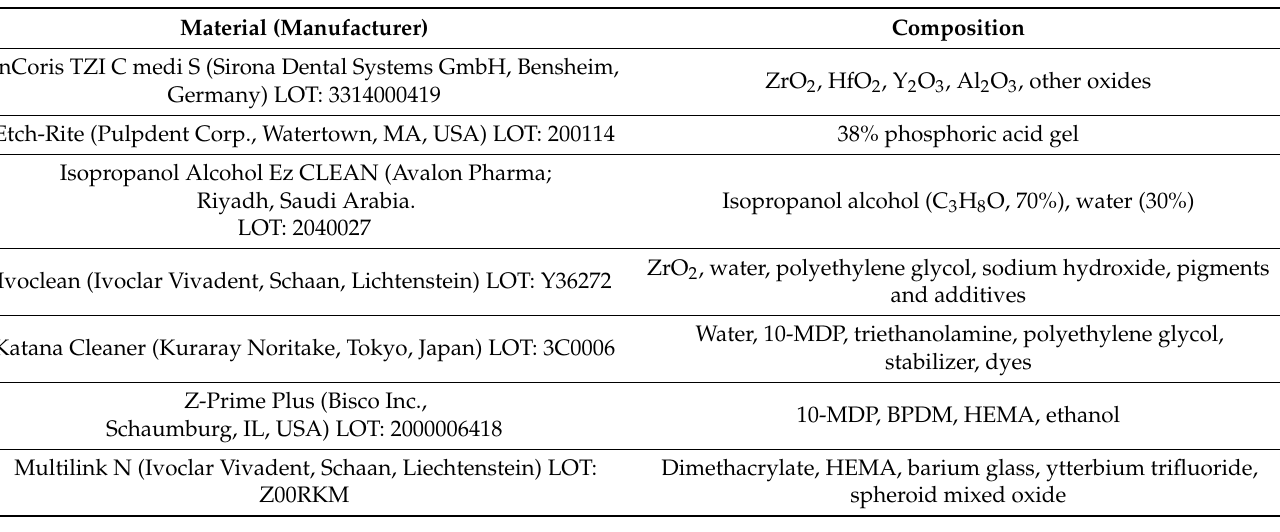
Table 1. Materials used in the study: